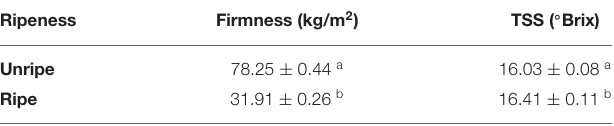
TABLE 1 | Initial values for firmness and total soluble solid content of unripe and ripe mangoes used for vacuum-frying experiments.